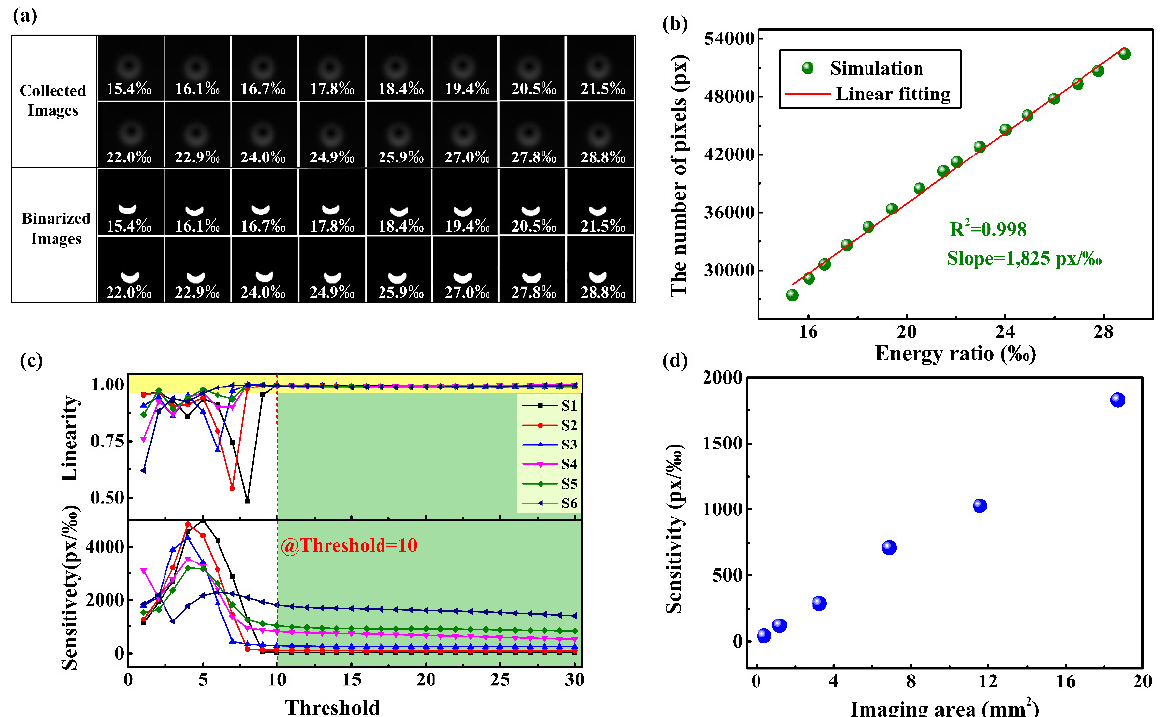
Figure 3. Numerical calculation of sensing principle. ( a ) The collected and binarized images of the intensity distributions in different energy ratio between the OAM 0 and OAM 1 mode; ( b ) the relationship between the energy ratio and the number of pixels with the gray value of 1; ( c ) the evolution of sensitivity and linearity of the sensor with the changes in imaging area and thresholds, and the size of imaging areas denoted by S1–S6 are 0.41 mm 2 , 1.21 mm 2 , 3.27 mm 2 , 6.88 mm 2 , 11.58 mm 2 , and 18.69 mm 2 , respectively; ( d ) the relationship between sensitivity and image area.